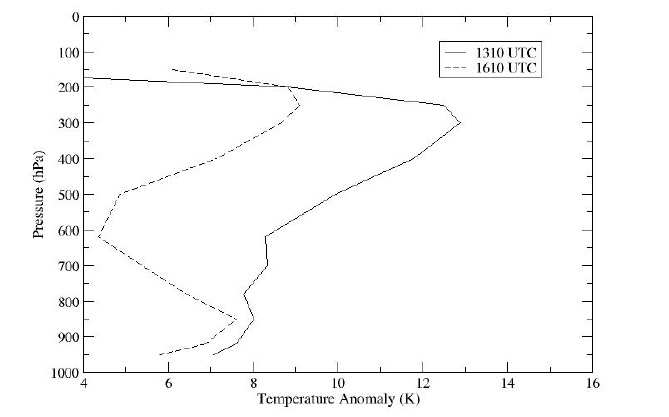
Figure 3. Temperature anomaly profiles from MODIS data for Terra pass at 1310 UTC and Aqua pass at 1610 UTC on 23 April